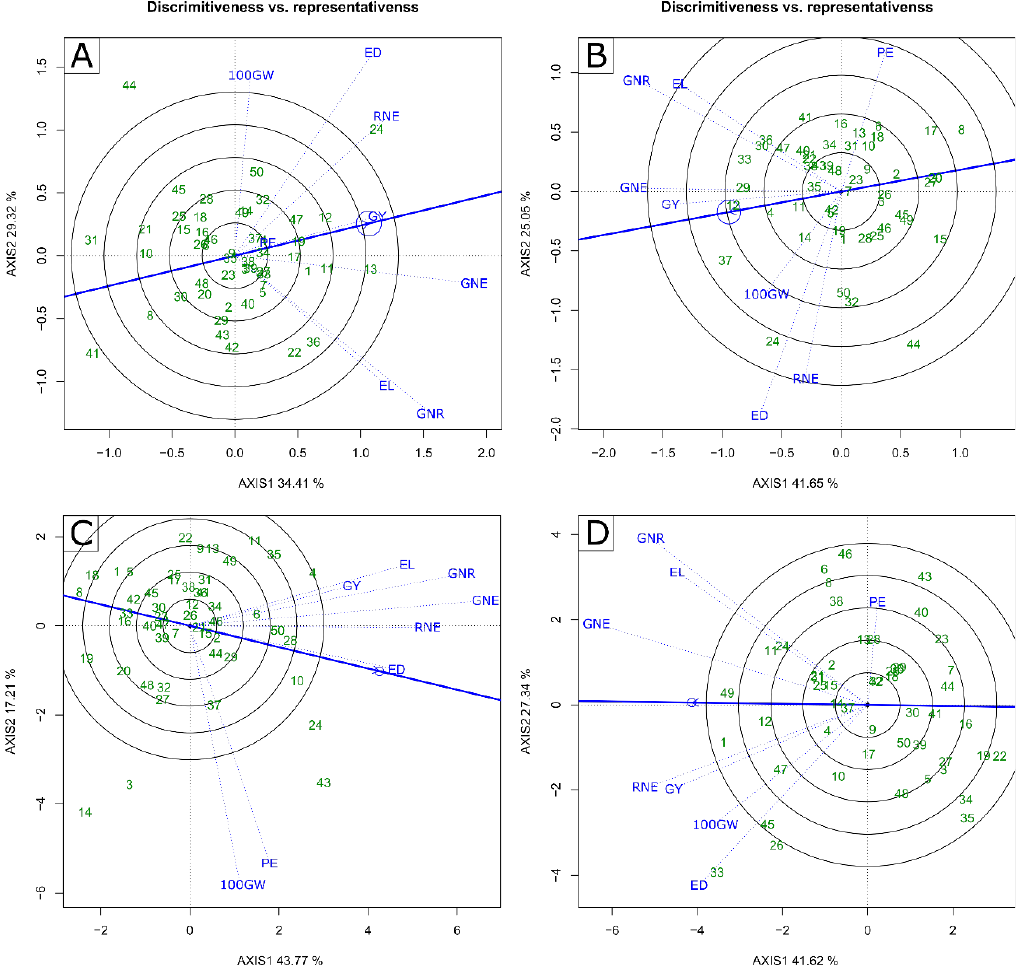
Figure 4. Biplot “Discrimitiveness vs. representativeness” graph ( A – C ) water stressed and ( B – D ) well-watered conditions in crop seasons 2020 ( A , B ) and 2021 ( C , D ). GY — grain yield; PE — Popping expansion; GNE — grain number per ear; 100 GW — 100-grain weight; RNE — Row number per ear; GNR — Grain number per row; ED — Ear diameter; EL — Ear length; (-) signal indicating negative values.